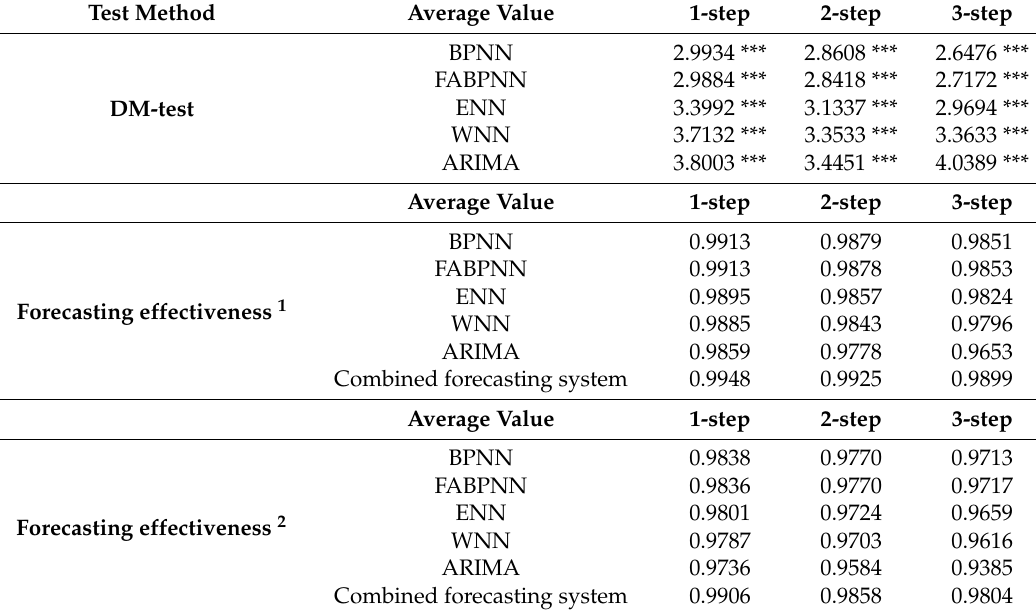
Table 11. Results for the DM test and the forecasting